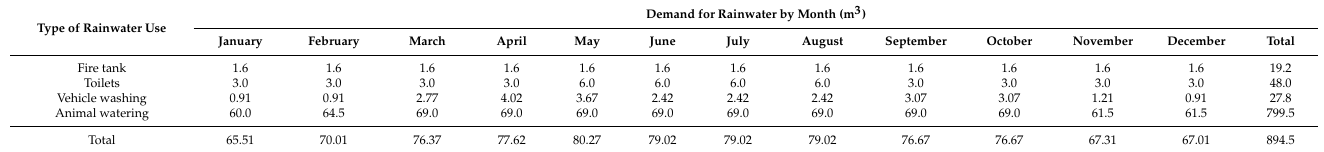
Table 3. Monthly demand for rainwater in the RNP’s Animal Breeding Centre in